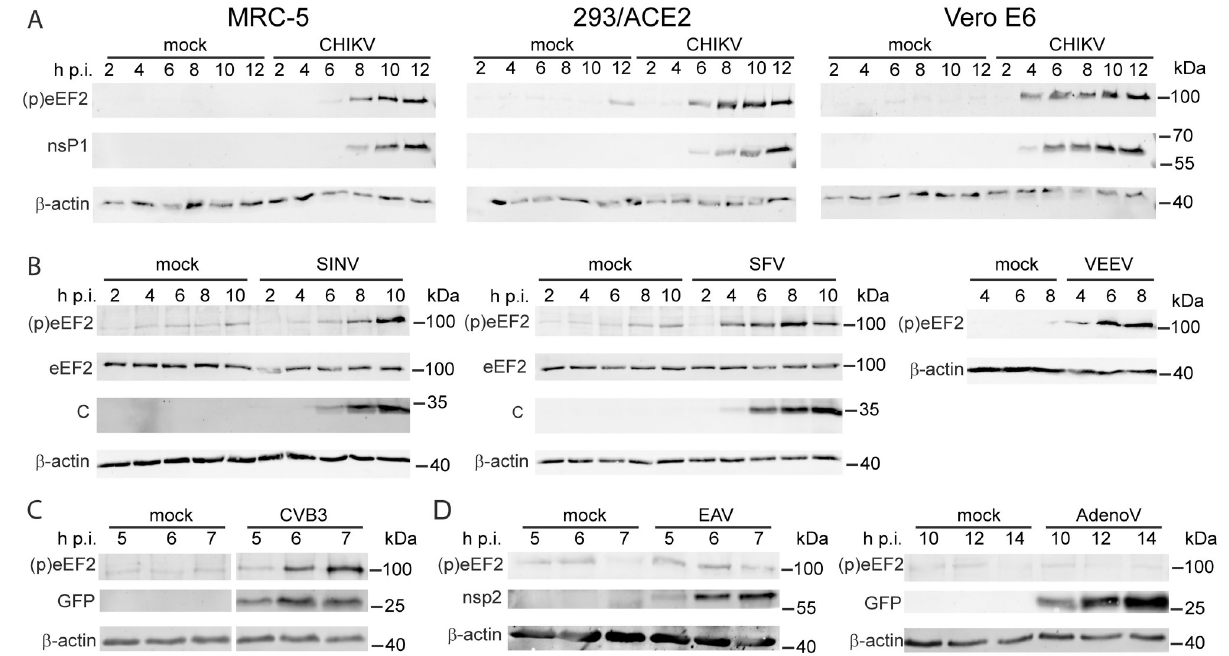
Fig 2. Alphavirus and enterovirus infection triggers early phosphorylation of eEF2 on T56. ( A ) eEF2 phosphorylation is triggered in CHIKV- infected MRC-5, 293/ACE2 and Vero E6 cells (MOI 5) at different time points post infection. Viral protein nsP1 and (p)eEF2 (T56) were detected by WB. ( B ) eEF2 phosphorylation is triggered in SINV- and SFV-infected Vero E6 cells at different time points post infection (MOI 5). Viral protein C, eEF2 and (p)eEF2 (T56) were detected by WB. ( C ) eEF2 phosphorylation is triggered in CVB3-GFP infected VeroE6 cells at different times post infection (MOI 1). GFP expression was used to monitor progression of the infection and (p)eEF2 (T56) was detected by WB analysis. ( D ) eEF2 phosphorylation is not triggered in EAV infected BHK-21 cells (MOI 5) or AdenoV-GFP infected Vero E6 cells. Viral protein nsp2 or GFP, and (p) eEF2 (T56) were detected by WB. Western blots are representative of at least two independent replicates.